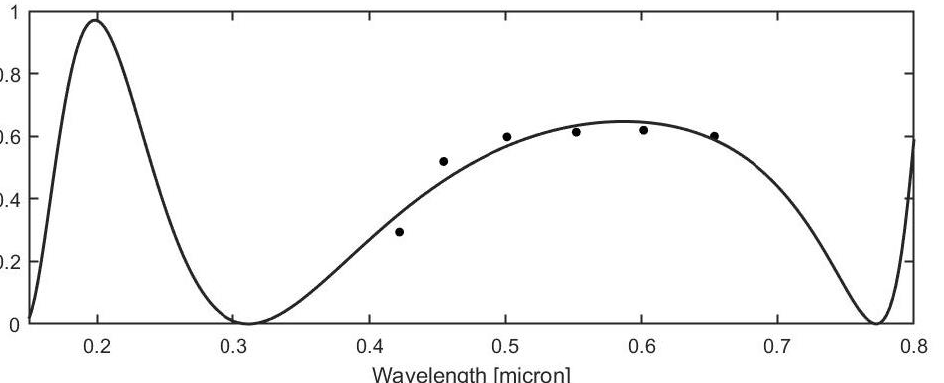
Figure 5. Data fit of the experimental values of the diffraction efficiency as a function of the